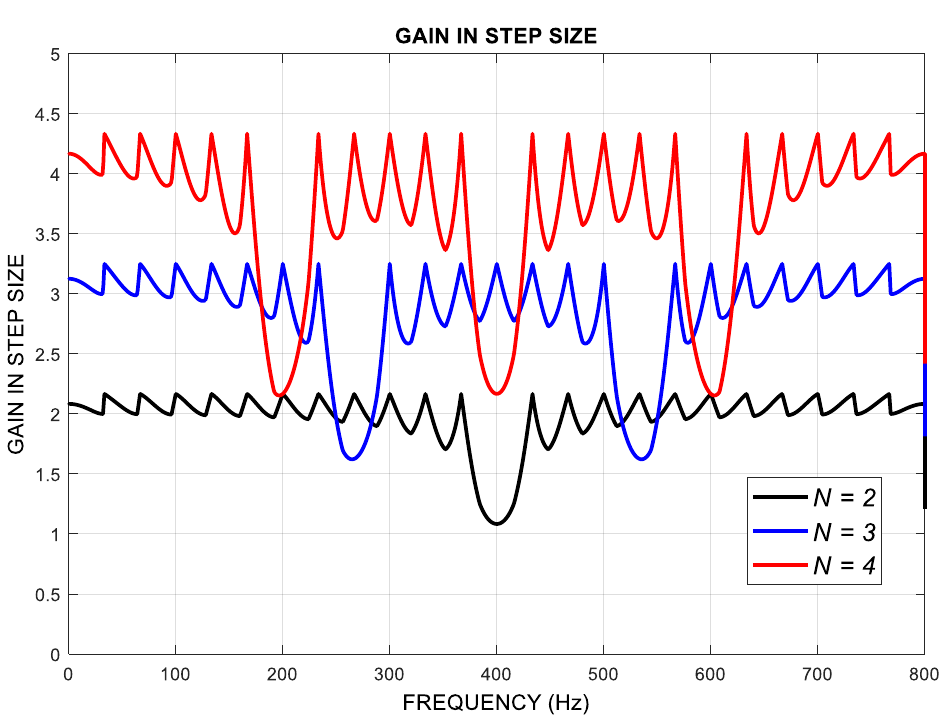
Figure 7. Theoretically predicted step-size gain of the G µ —Mod Fx H Seq PU LMS over the frequency band of interest—from 0 to 800 Hz—for N = 2, 3, and 4. L = 625 taps are organized in 25 subfilters of β = 25 weights.